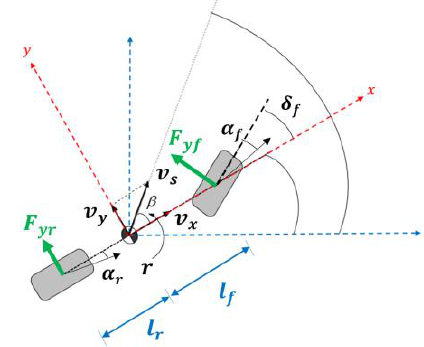
Figure 1. Diagram of the vehicle bicycle model.